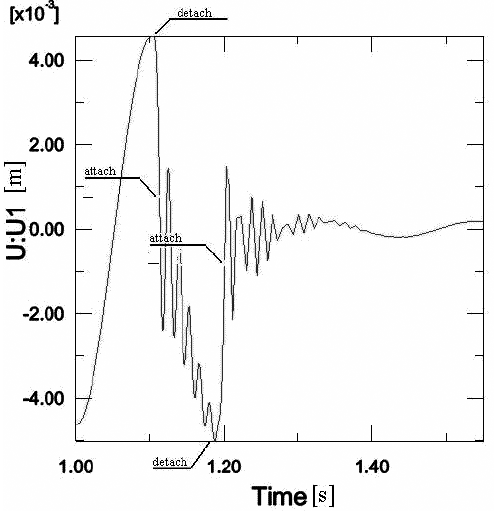
Fig. 6. Middle mass response with indicated points corresponding to activating